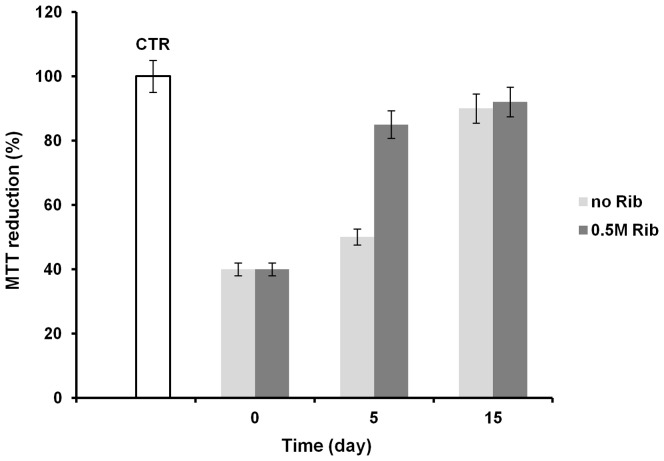
Effect of ribosylation on the cytotoxicity of the W7FW17F apomyoglobin aggregates.NIH-3T3 cells were exposed to aggregates formed in the absence (light grey) and in the presence of D-ribose (dark grey). Aliquots of protein were taken at 0, 5 and 15 days from the onset of aggregation and incubated for 24 h with cells. Data are expressed as average percentage of MTT reduction ±SD relative to cell treated with medium alone or medium plus D-ribose, from triplicate wells from 5 separate experiments (p<0.01). The white bar represents the negative control (cells treated with medium plus 0.25 M D-ribose). Other experimental conditions are described in the Materials and Methods section.